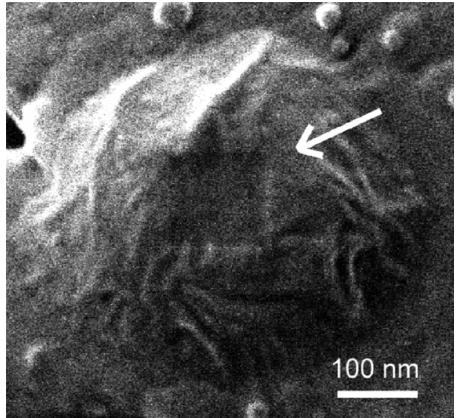
Figure 12 Nanolithography with HIM. 100 nm × 100 nm square hole milled on top of 200 nm diameter PVDF particle.